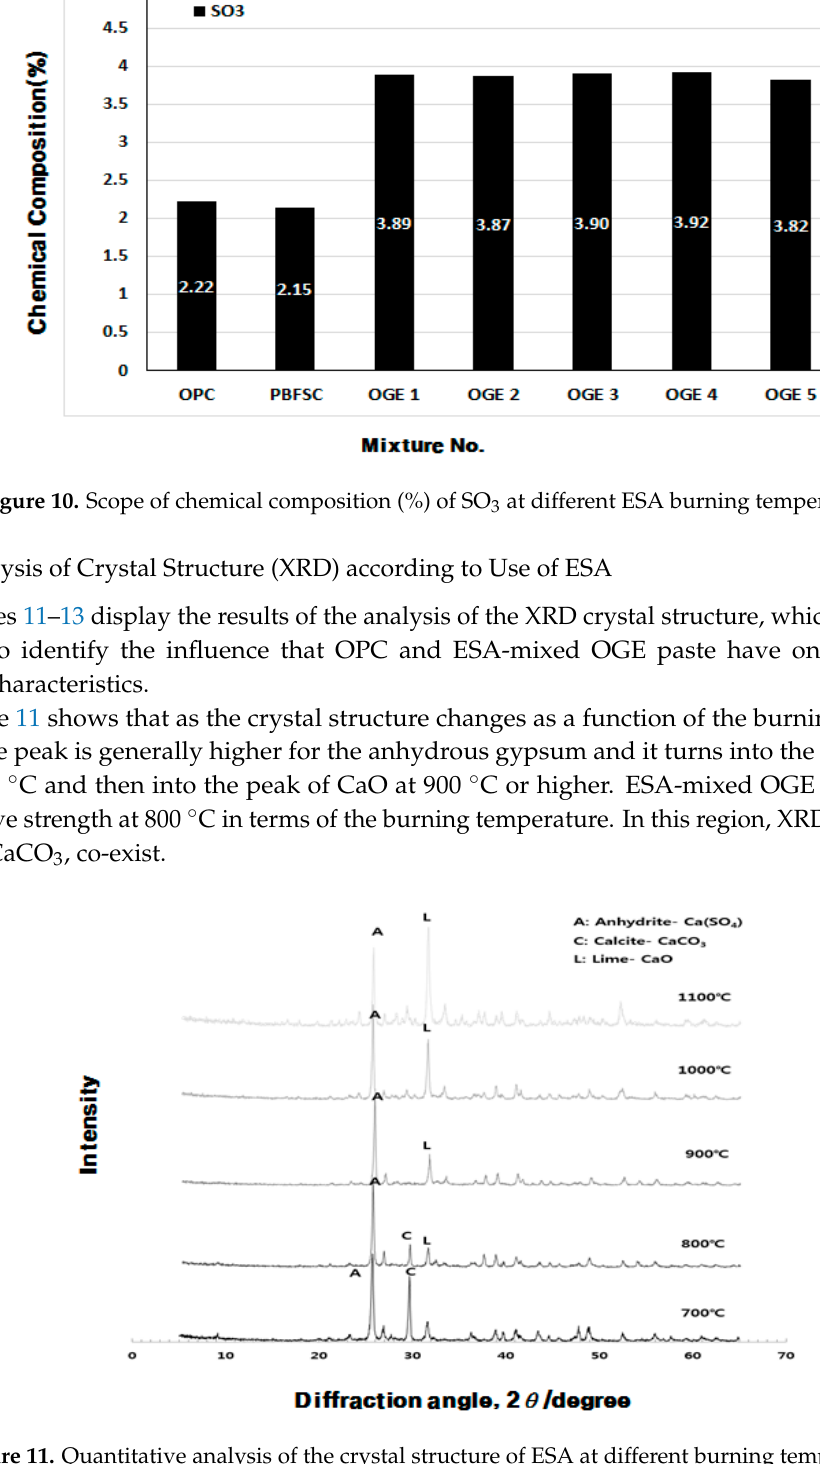
Figure 9. Change in ESA chemical composition (%) at different burning temperatures.